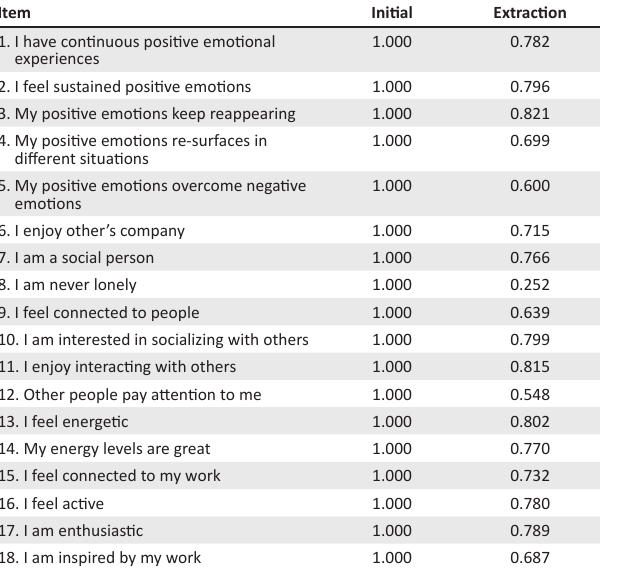
TABLE 2: Communalities of the factor loadings.